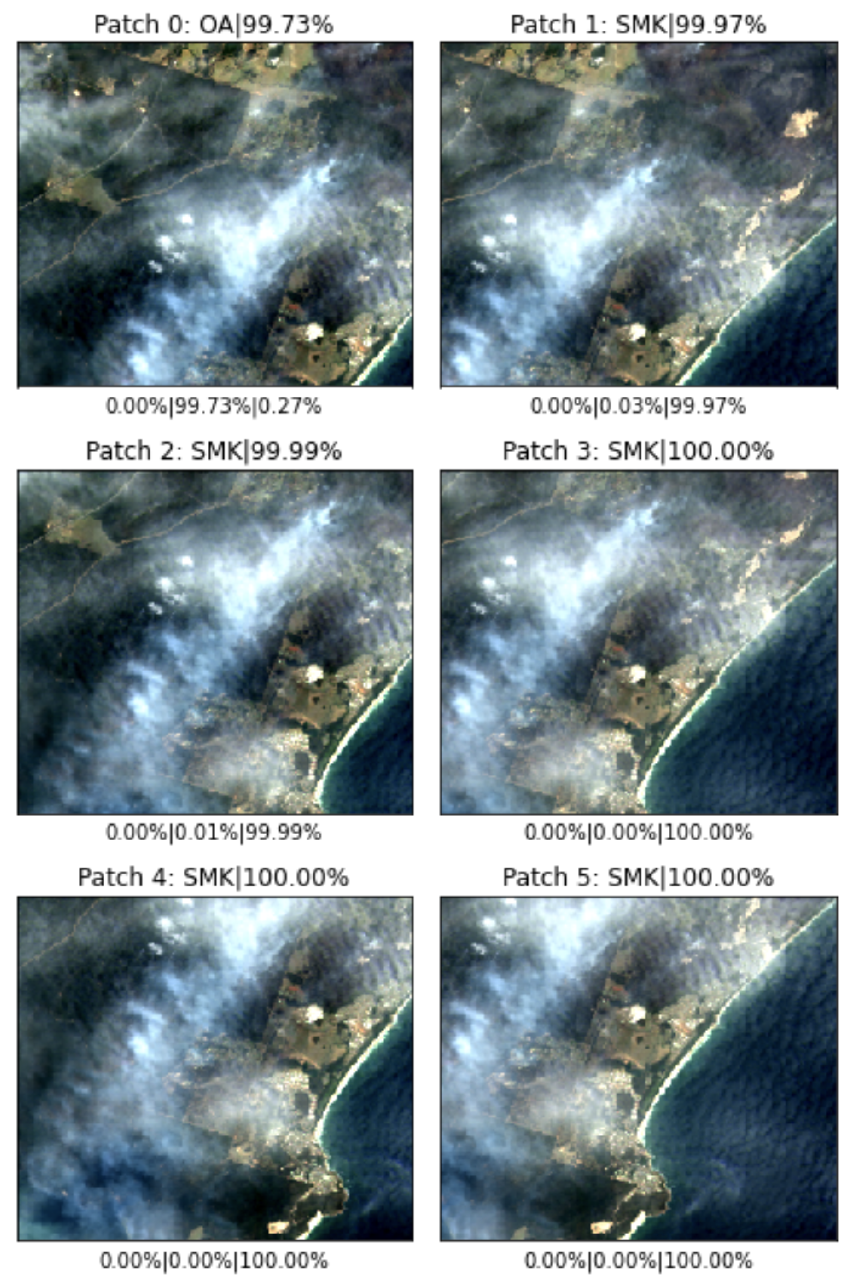
Figure 10. Prediction results of scene (a) in Figure